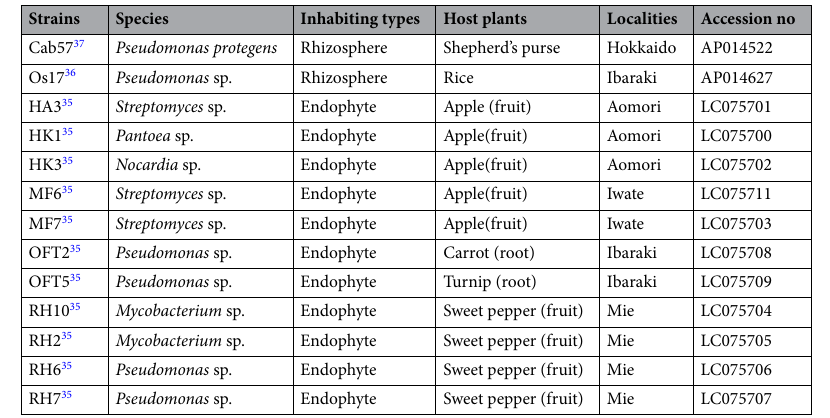
Table 1. Bacterial strains used in this study, which were isolated from various plant species in different prefectures (localities) in